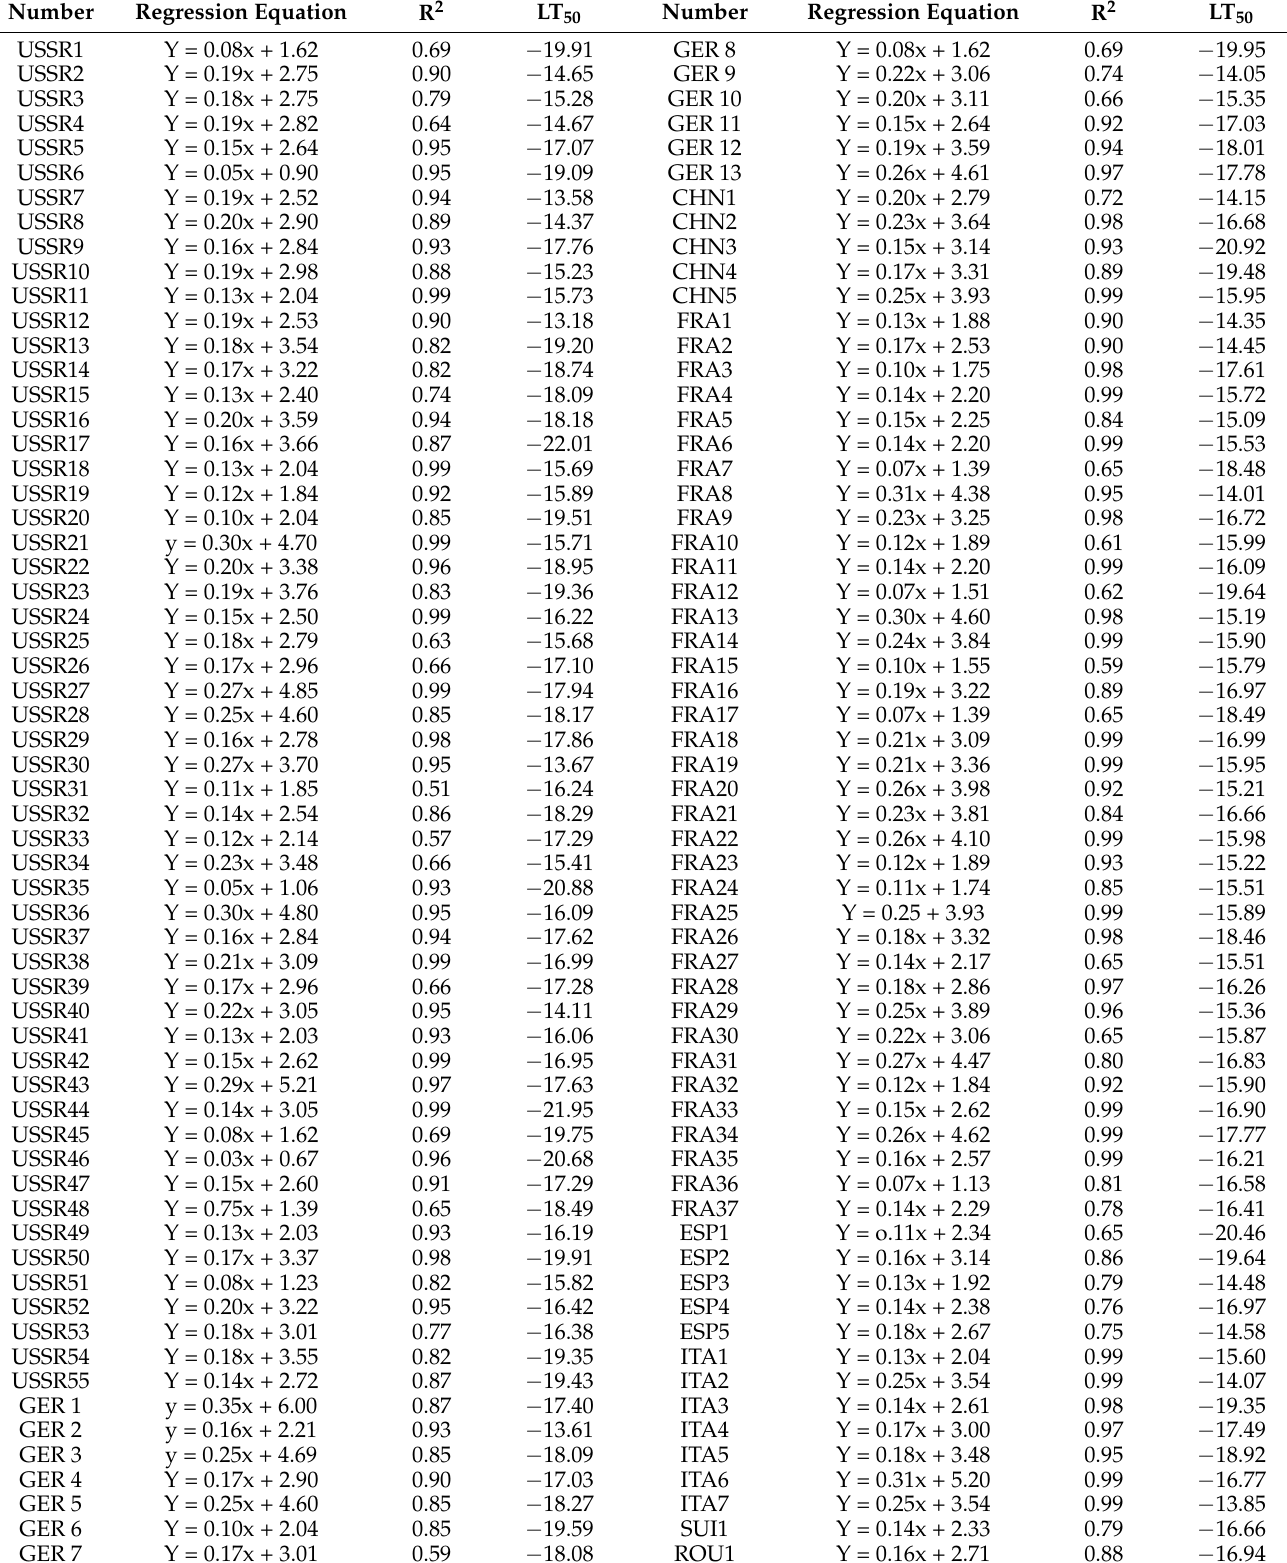
Table 2. LT 50 values of 124 germplasms subjected to different cryogenic